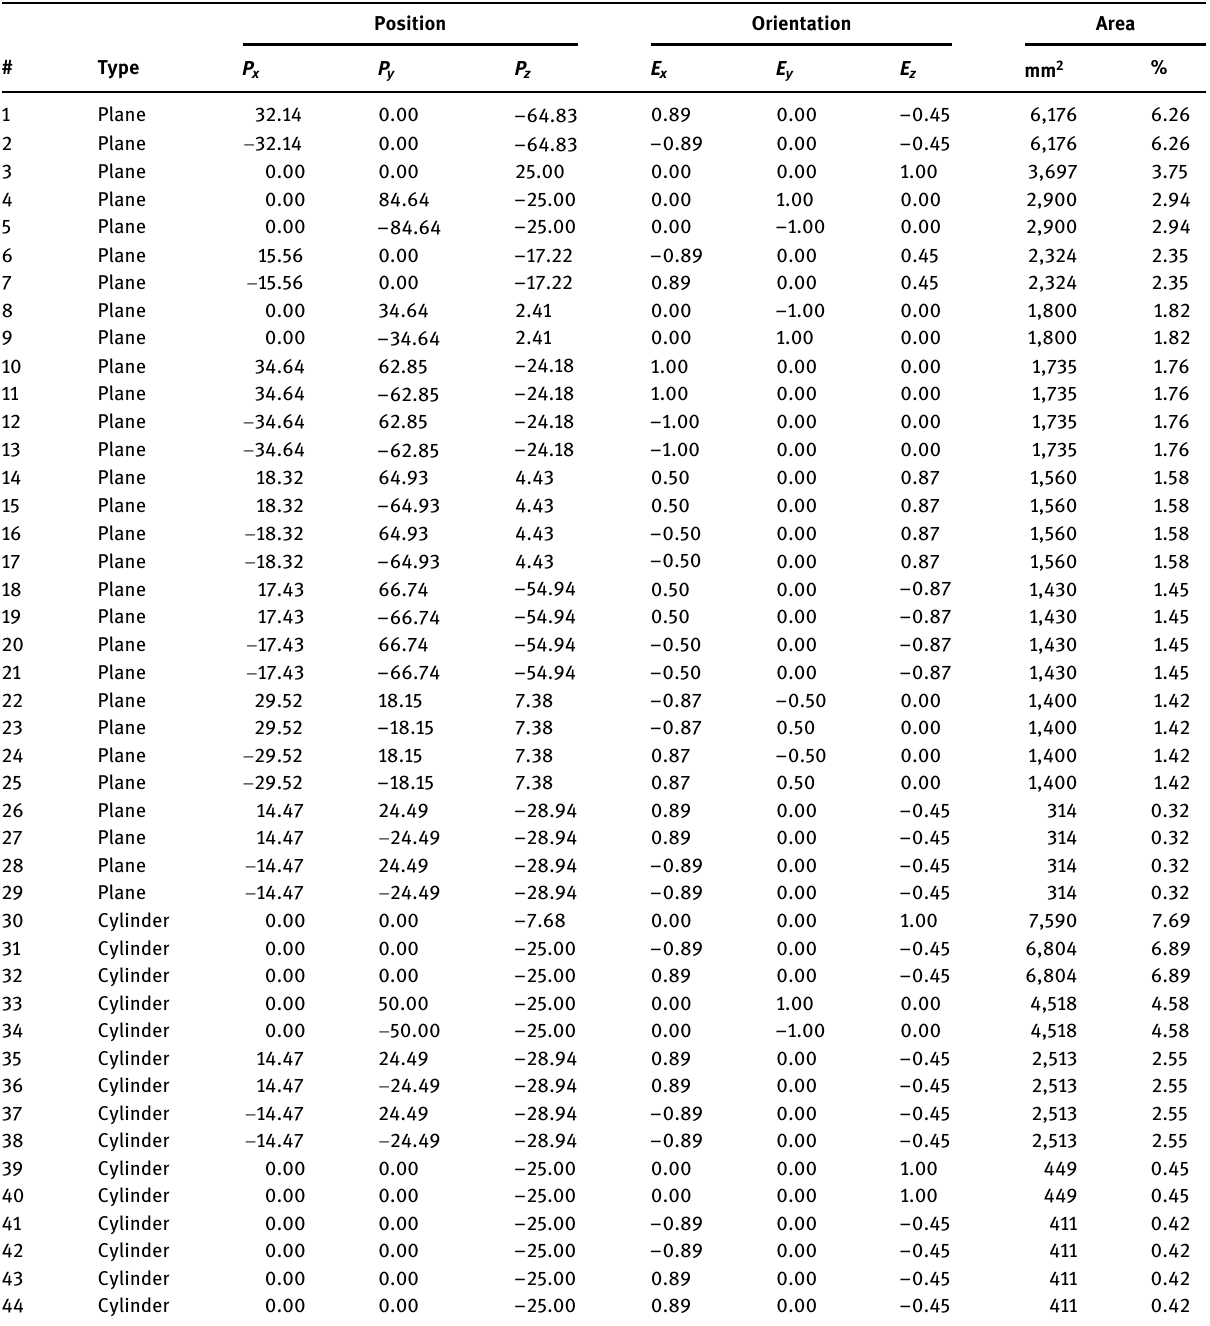
Table 5: Numeric description of features for sample part